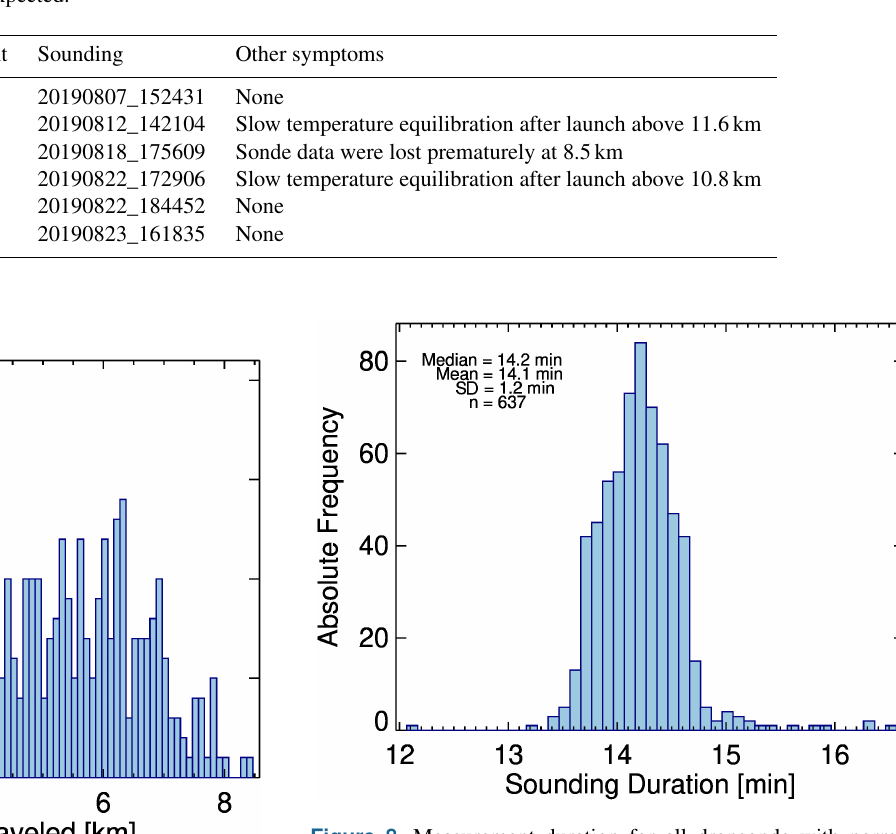
Table 8. Sondes falling slower than expected.